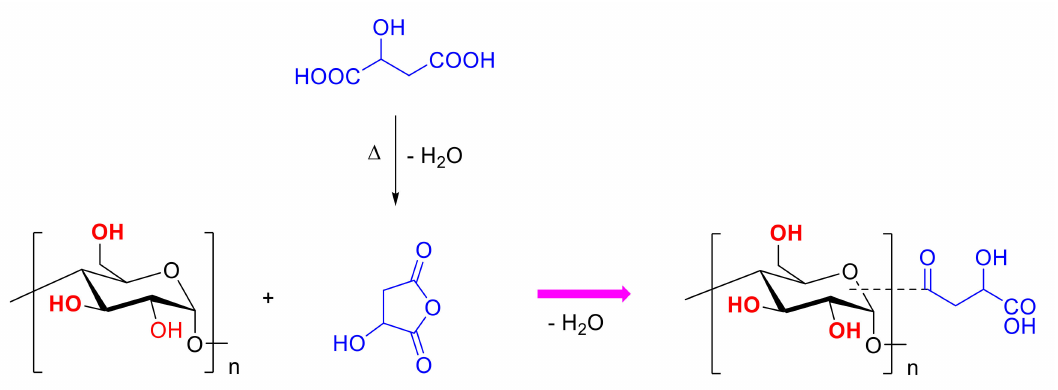
Figure 5. Reaction equation of starch and malic acid.